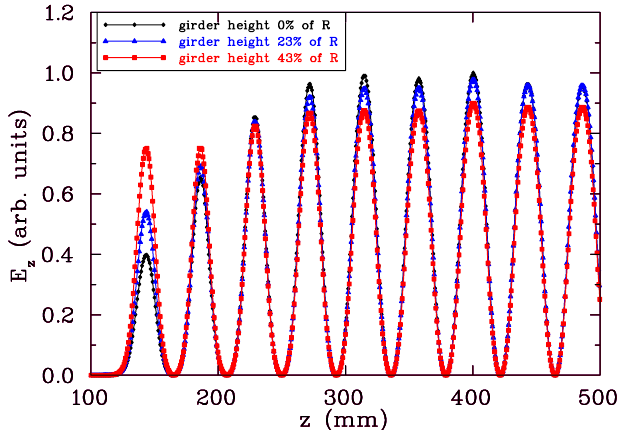
FIG. 7. (Color) Simulated electric gap field distribution for three different girder heights (0%, 23%, and 43% at a constant tank radius R (cid:1) 140 mm ). The girder height of 0 : 43 R corresponds to the prototype geometry. Because of the cavity symmetry only one-half of the length is shown. Each gap voltage corresponds to the local magnetic flux [see Eq.